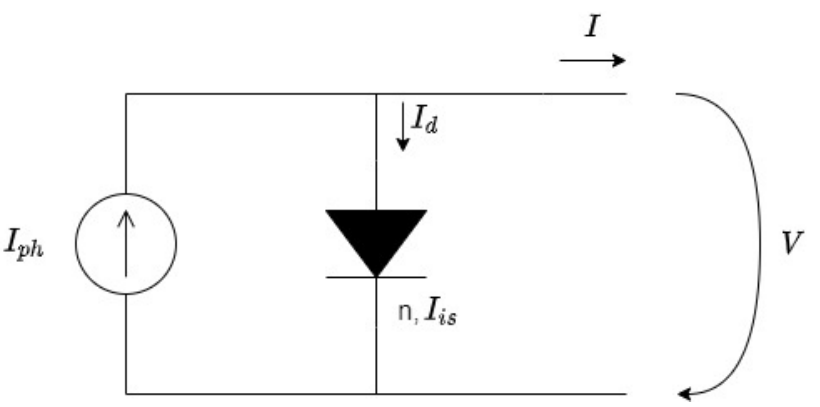
Figure 4. Electrical equivalent circuit of a solar cell: 1M3P.